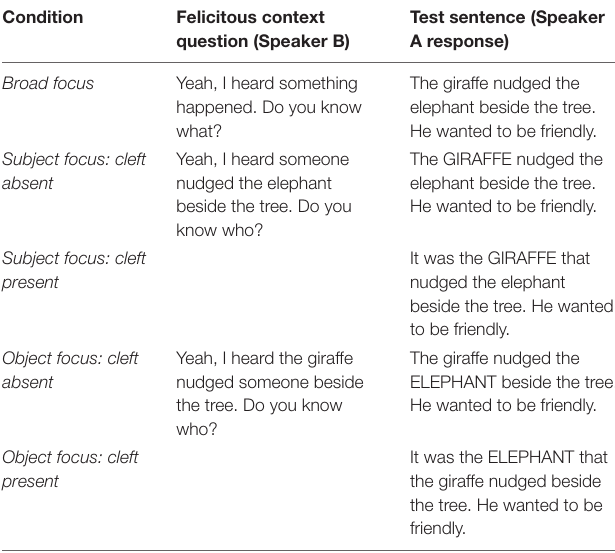
TABLE 1 | Example illustrating experimental conditions.